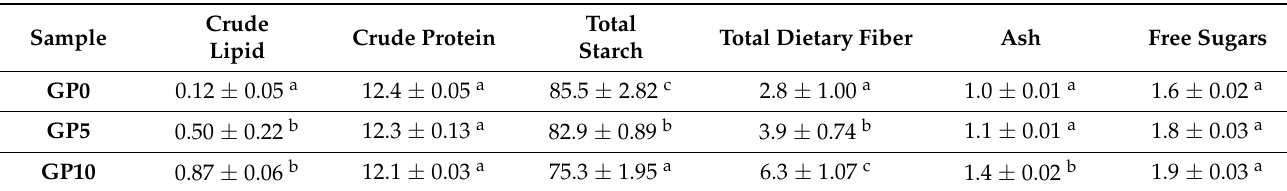
Table 5. Chemical composition (g/100 g dry matter) of experimental breads formulated with increasing levels of grape pomace powder (GPP) in the recipe.